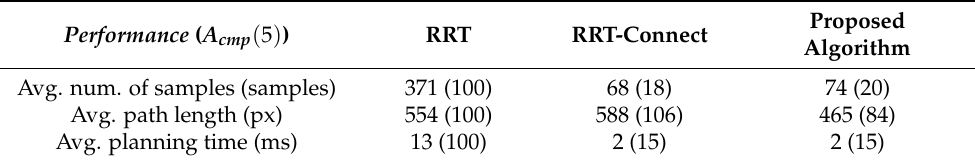
Table 6. Experimental result of Map 5 (the parentheses to the right of each value are the relative ratios based on RRT 100% ( x cmp ( 5 ) )).